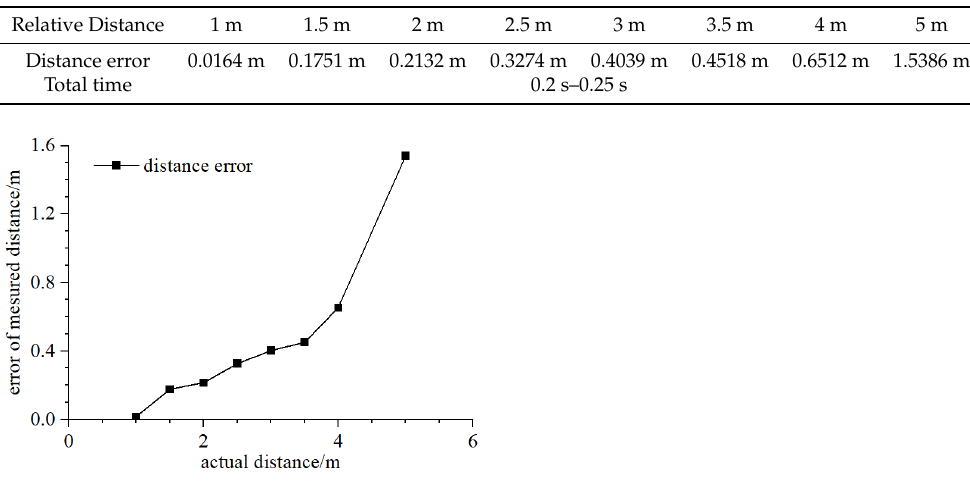
Figure 13. Error of relative distance estimation.